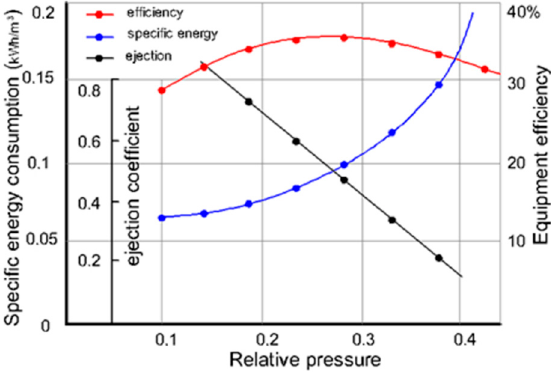
Figure 6. Dependency graphs α _e, η _u N_u = f(h_e).